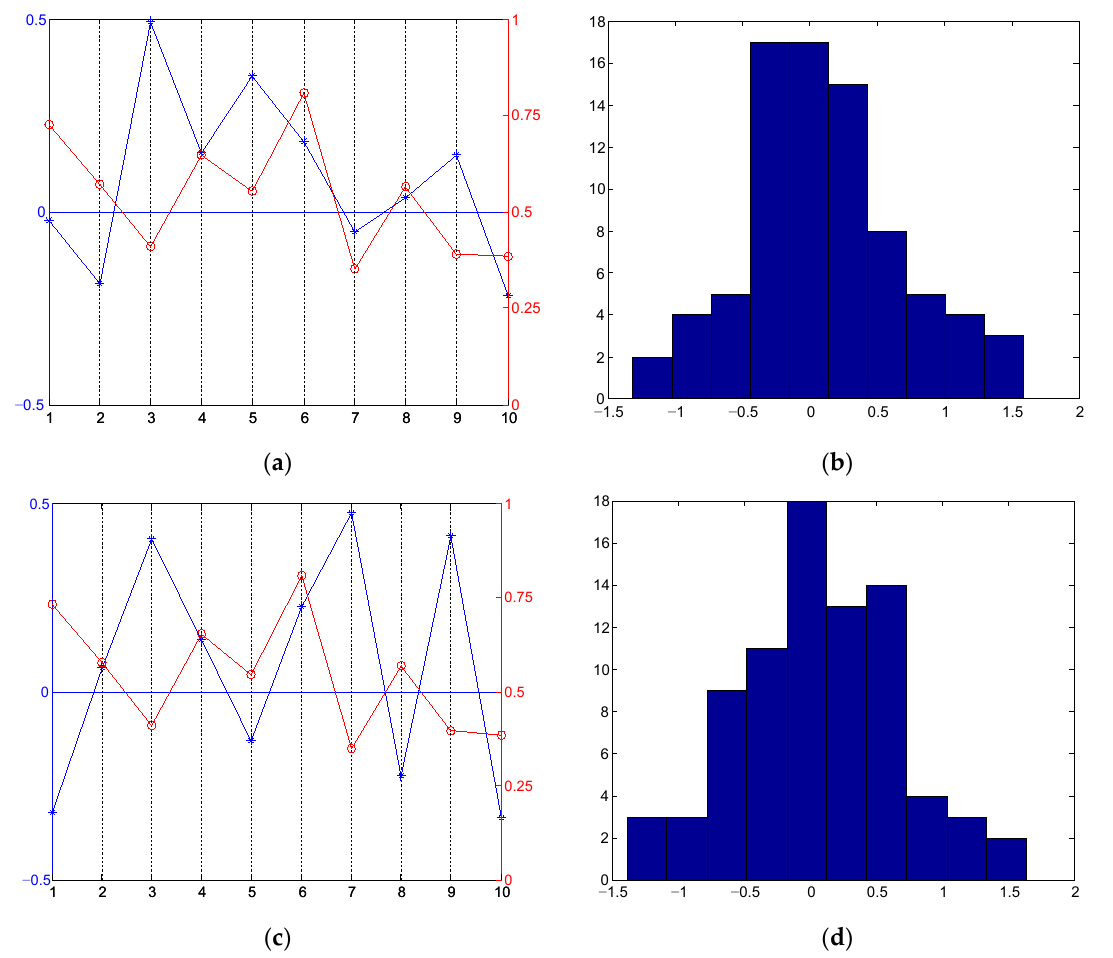
Figure 20. Mean value, standard deviation and distribution of elevation difference of tie-points between strips, where ( a , b ) are the results based on tie-points, ( c , d ) are the results based on marking points. Additionally, the abscissa in the ( a , c ) is the number of data stacks between strips, and the left and right ordinate in the ( a , c ) are mean elevation difference (blue) and standard deviation (red) of tie-points in data stacks between strips whose unit is m, respectively. Additionally, the abscissa in the ( b , d ) is elevation difference (in meters) of data stacks between strips, and the ordinate in the ( b , d ) is the number of tie-points corresponding to elevation difference.